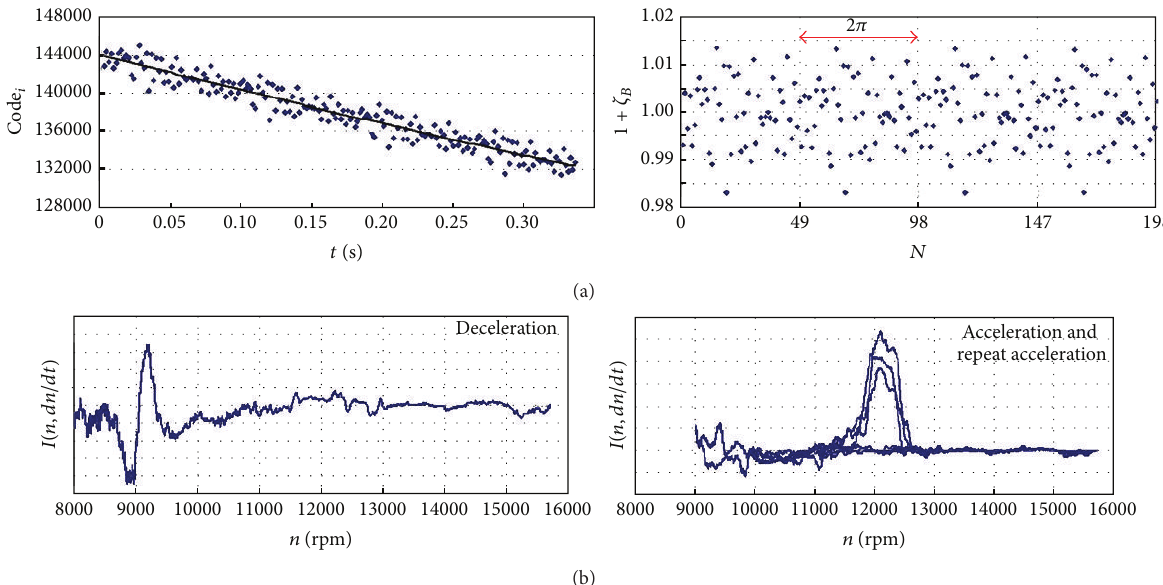
Figure 20: Result of the DETREND procedure for TOA (𝑘) signal measured for (a) the last stage of SO-3 engine compressor (49 blades in the palisade)—the pitch errors are dominating in the jitter 𝜁 𝐵 ; (b) the first stage of SO-3 engine compressor—the component 𝐼(𝑘) = 𝐼(𝑛, 𝑑𝑛/𝑑𝑡) is revealing the influence of some asynchronous parts of jitter 𝜁 𝜔 on the component 𝐴(𝑘) (e.g., rotor vibration, fluctuation in the rotational speed on the compressor limits)